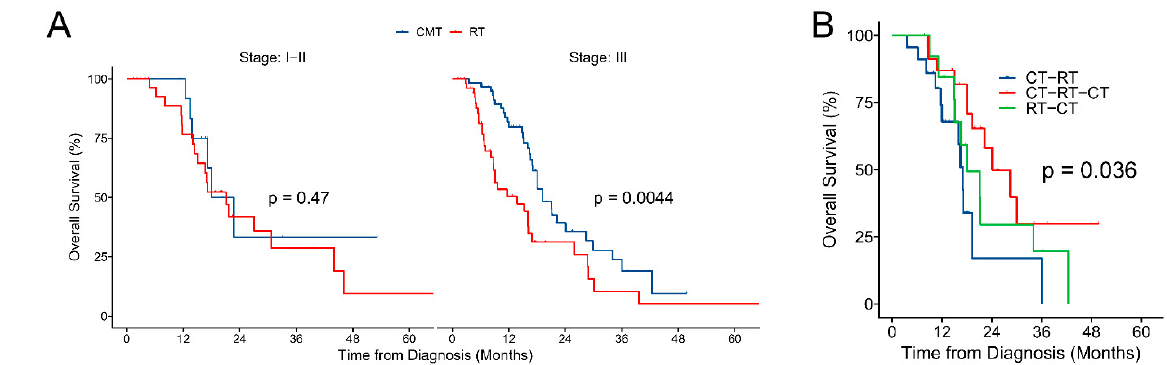
Figure 3. Survival analysis according to treatment modalities by stage. ( A ) Overall survival (OS) from diagnosis with radiotherapy alone (RT) or combined modality therapy (CMT) in patients with stage I–II and III disease; ( B ) OS from diagnosis with di ff erent sequence of radiotherapy (RT) and chemotherapy (CT) in patients with stage III disease treated with CMT.